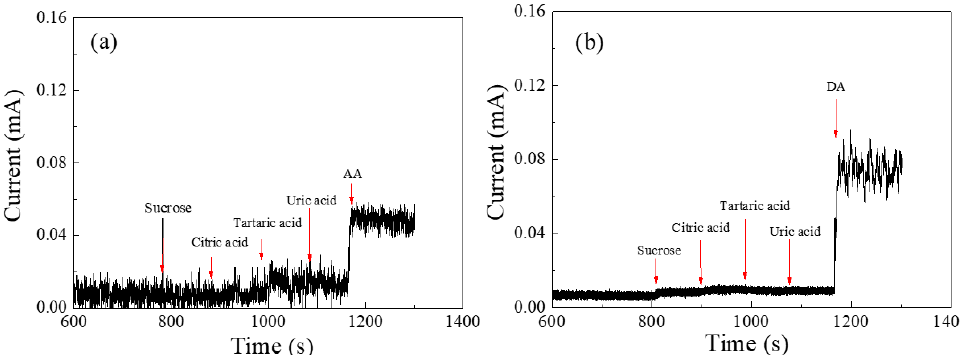
Figure 9. Selectivity of the Pt-Mo/C/GCE for the detection of ( a ) AA; and ( b ) DA in the presence of sucrose, citric acid, tartaric acid, and uric acid at a concentration of 0.5 mM. The reproducibility of Pt-Mo/C/GCE was determined using five independent Pt- Mo/C/GCEs for sensing AA and DA and the results are shown in Figure 10a. The sensi- tivity of each electrode divided by the sensitivity that is measured by the first electrode is defined as the normalized sensitivity. The results show that Pt-Mo/C/GCE had acceptable sensitivity, and the respective standard deviations for detecting AA and DA were 7.07% and 5.45%.